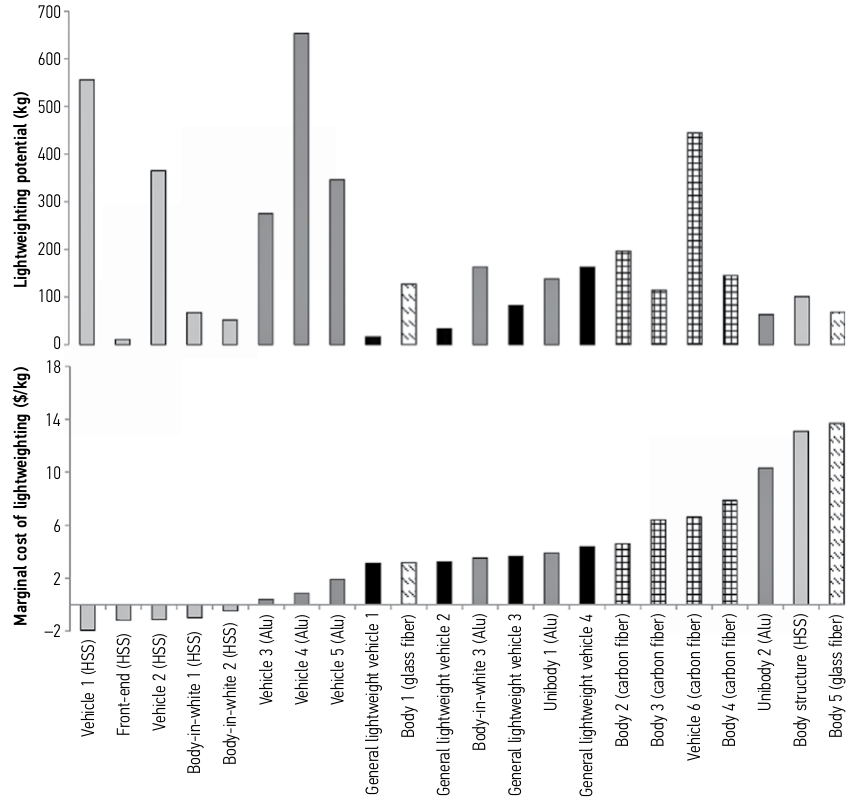
Fig. 5. Estimates for the marginal cost of lightweighting technology sorted from lowest to highest and